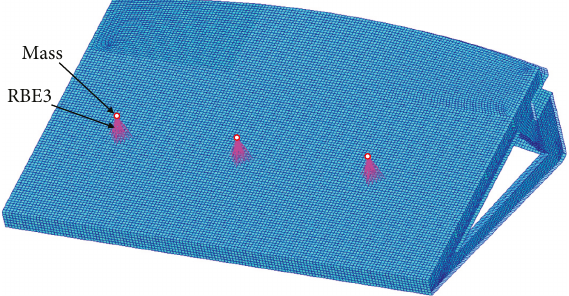
Figure 10: Mass on the inertial bracket.